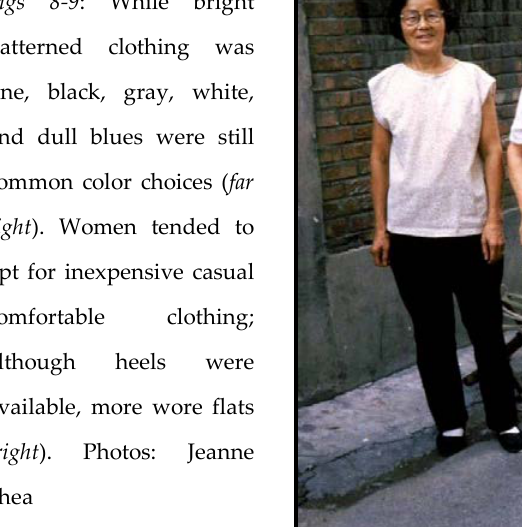
Figs 8-9 : While bright patterned clothing was fine, black, gray, white, and dull blues were still common color choices (